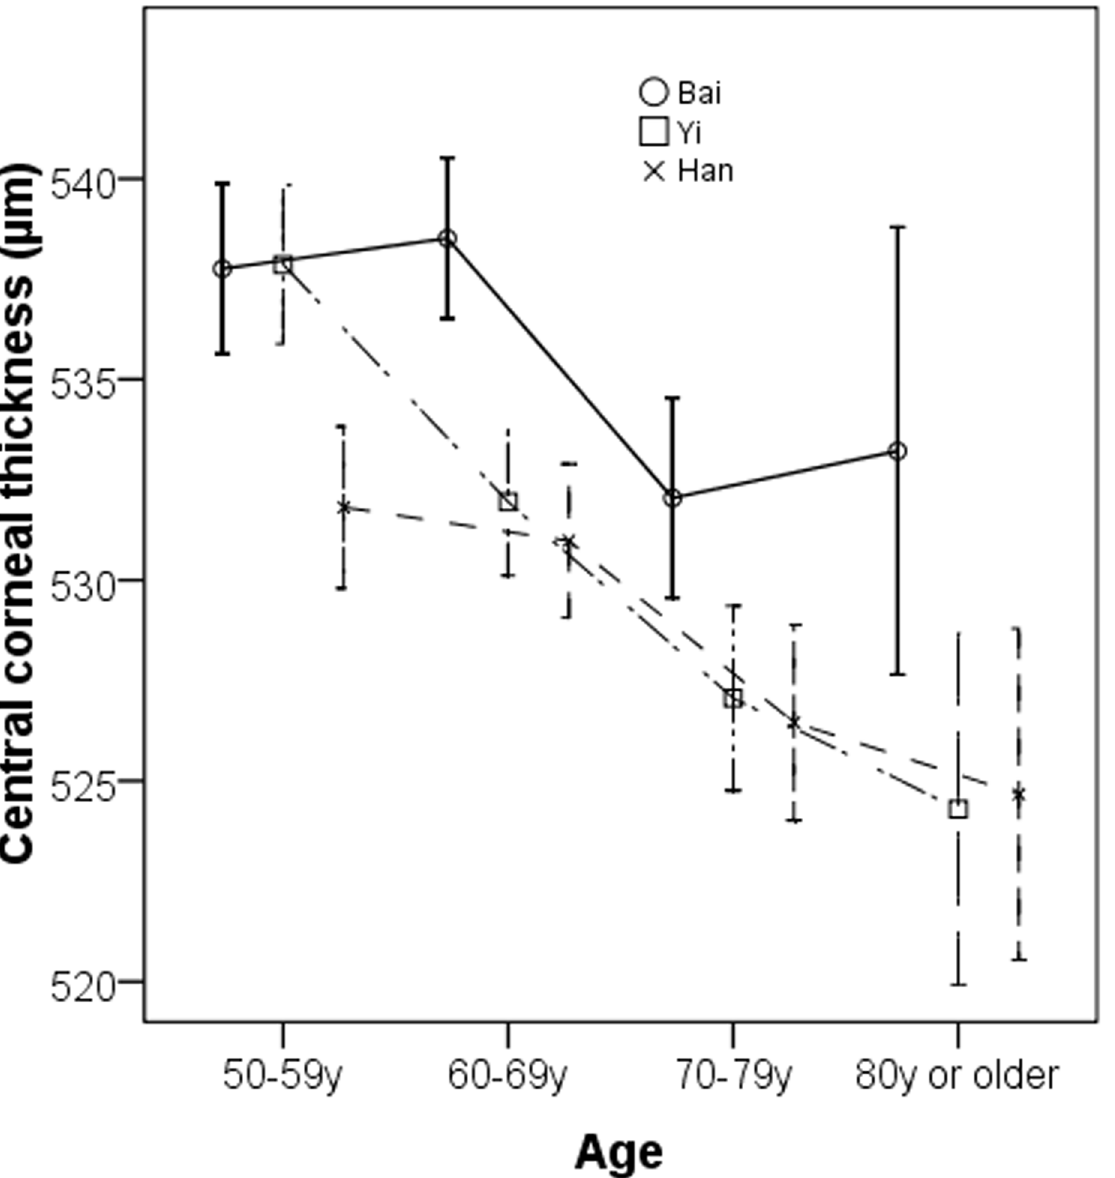
Fig 2. Age-specific mean central corneal thickness among the three ethnic